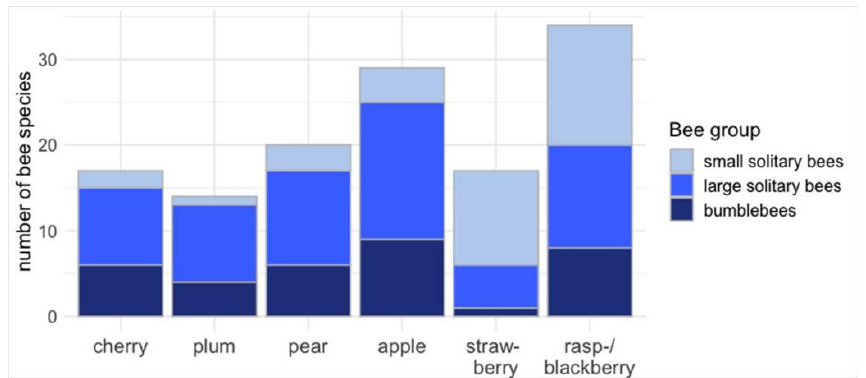
Figure 4. Number of wild